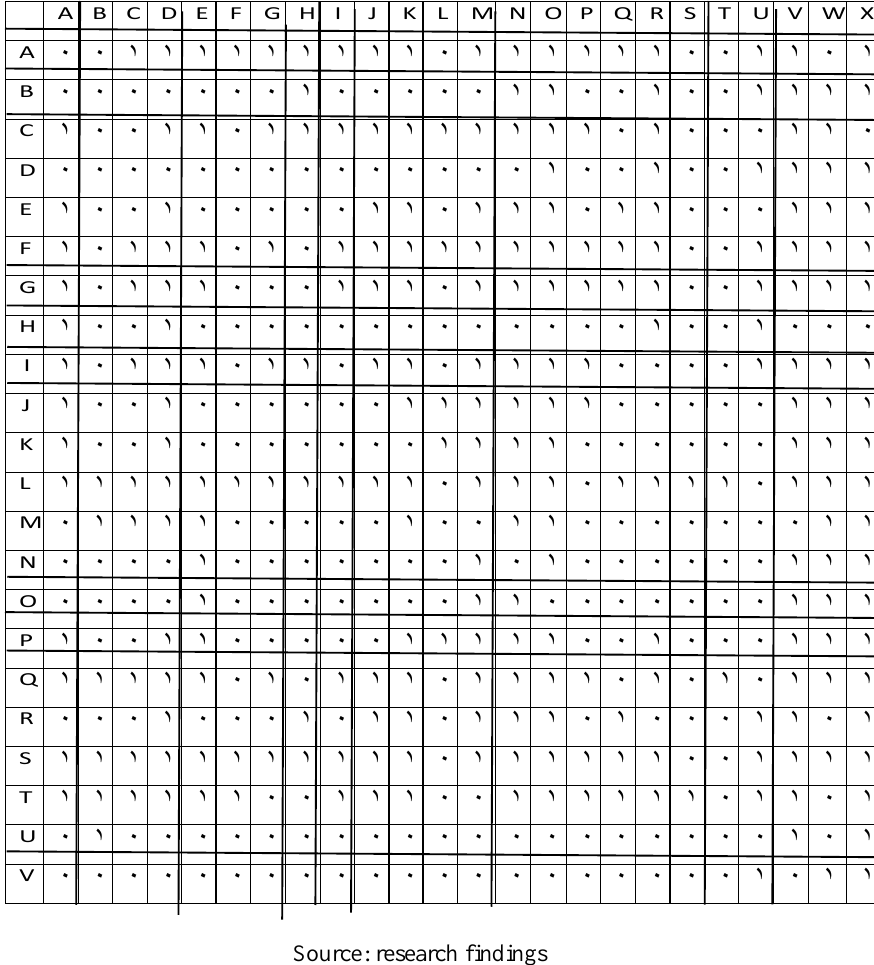
Table 2. The initial access